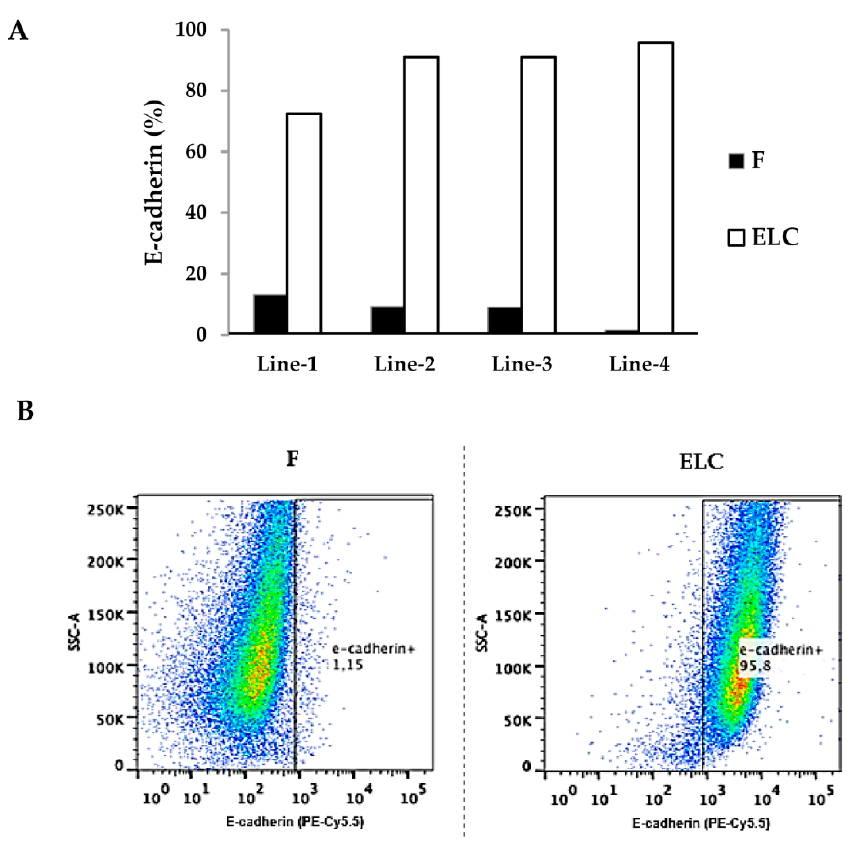
Figure 4. E-cadherin was increased in ELC derived from human lung fibroblasts. The fibroblast-rich culture plates obtained from different passages of the same cell line were compared with the correspondent ELC. The cells were fixed, labeled with an E-cadherin (CD324) antibody (PE-Cy5.5), and analyzed by cytofluorometry. Percentage of cells expressing E-cadherin in four different fibroblast and ELC lines ( A ): two were obtained from ILD patients (Line-1 and Line-2), and two from brain dead patients (Line-3 and Line-4). Representative scatter dot-plot images of flow cytometry for E-cadherin in fibroblasts and ELC ( B ). F: fibroblast; ELC: epithelial-like cell.